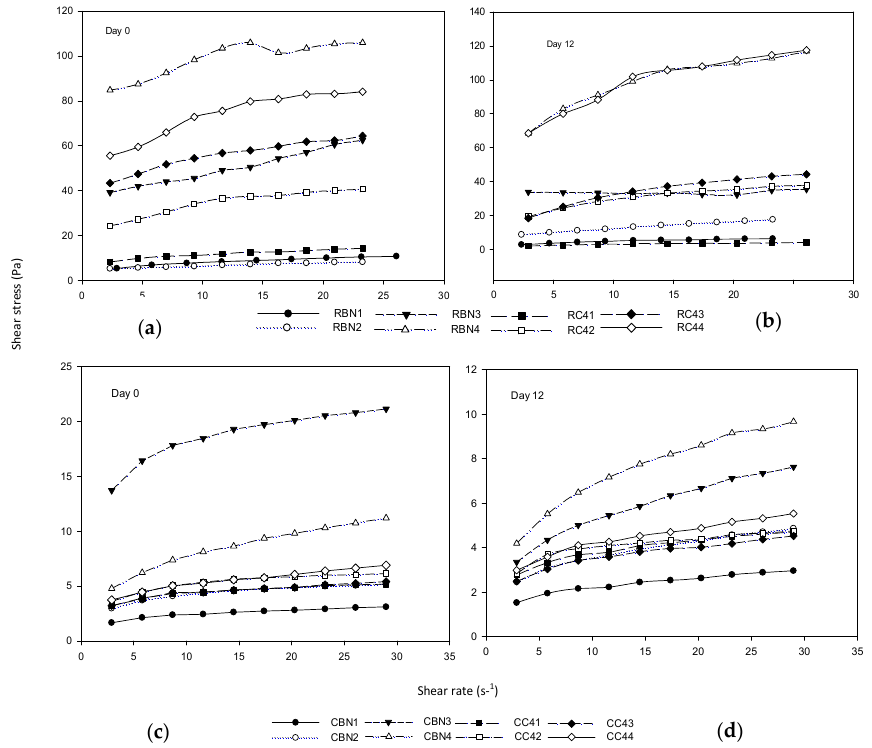
Figure 1. Flows curves of dairy desserts at 0 and 12 days, ( a ) and ( b ) correspond to raw flours (R) and ( c ) and ( d ) correspond to cooked flour (C). BN: Blanco Noroeste; C4: Costa 2004.